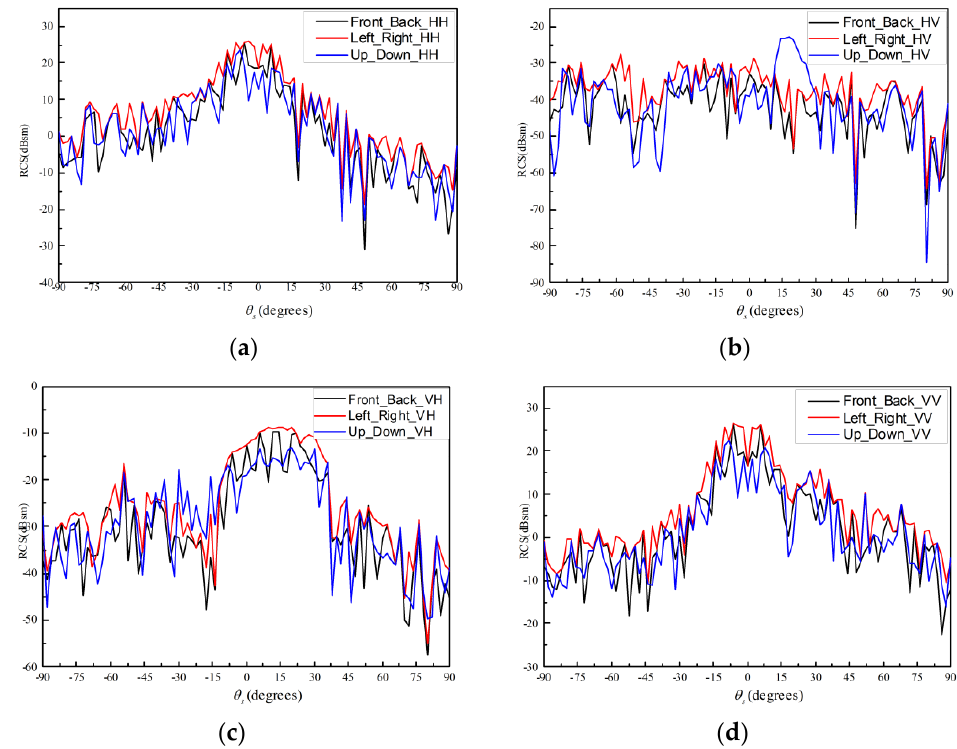
Figure 6. The monostatic RCS of two PEC missile−like targets: ( a ) in the HH polarization; ( b ) in the HV polarization; ( c ) in the VH polarization; ( d ) in the VV polarization.